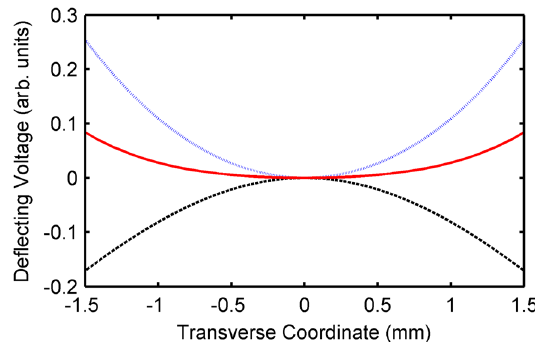
FIG. 13. Gain in the deflecting voltage in the accelerating stripline gap (dotted blue curve), the aperture channel (dashed black curve) and the sum of the two (solid red curve) vs transverse